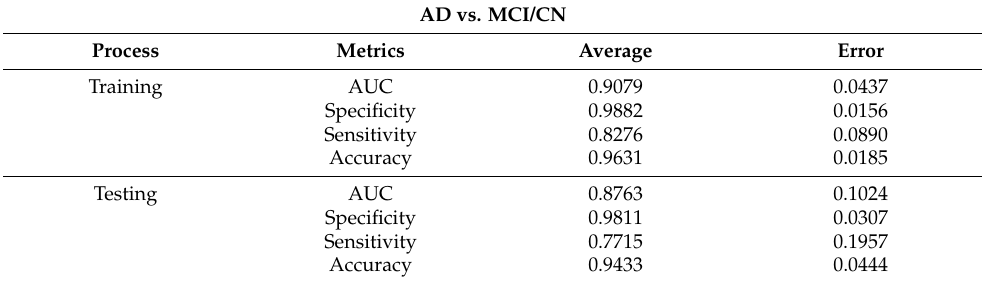
Table 5. Performance metrics obtained by k-fold cross-validation of the ADvsMCI/CN-m1 model.